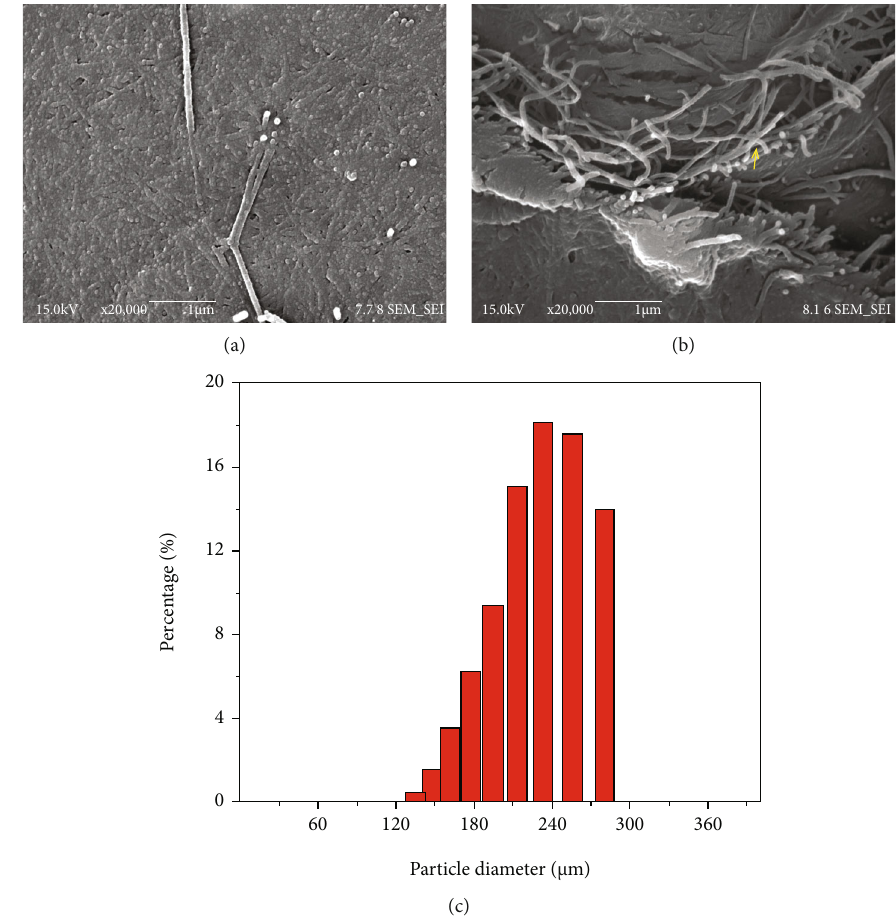
Figure 2: FE-SEM of (a) BC fi lm, (b) the NDCt fi lm, and (c) NDCt size in suspension after measuring using a PSA.